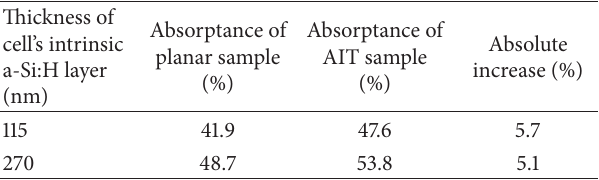
Table 2: AM1.5G weighted average absorptance of the four solar cell precursor samples of Figure